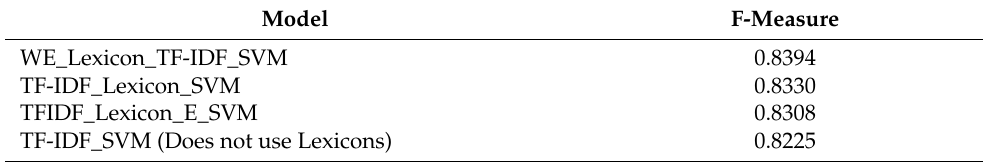
Table 9. Hybrid models outperforming the best non-Lexicon model in the Mexican corpus. Table 8. Hybrid models outperforming the best non-Lexicon model in the Chilean corpus.